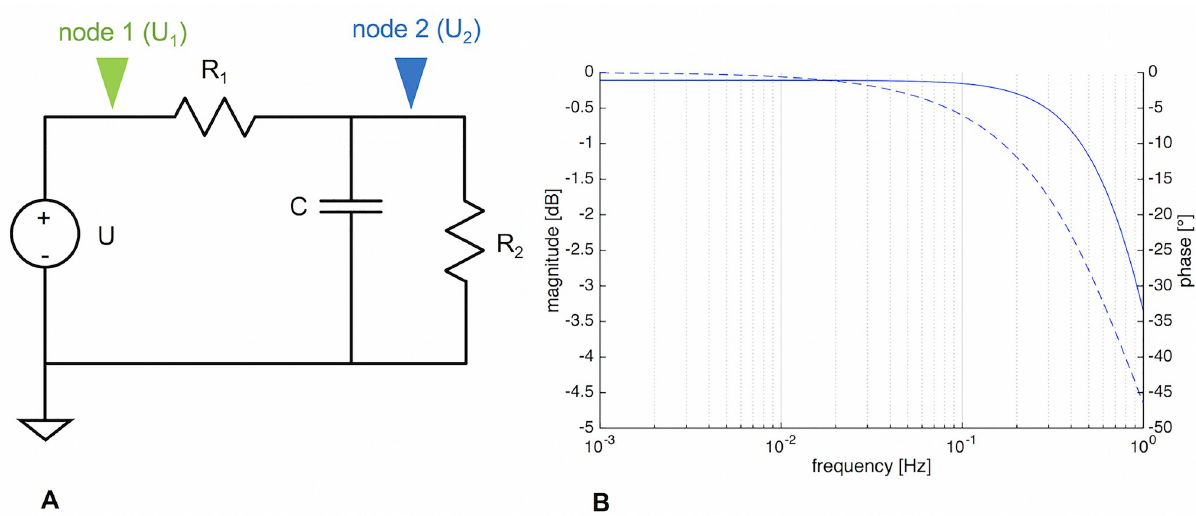
Fig 12. LTSpice schematic and resulting Bode plot of a three-element Windkessel. A) Schematic of 3-element Windkessel. U = voltage source, R 1 , R 2 = resistors, C = capacitor. Green arrow = node 1, blue arrow = node 2. B) Bode plot of the circuit, taken at node 2. The cut-off frequency can be obtained mathematically, or it can be found from the Bode plot at the frequency where the gain falls below—3 dB.